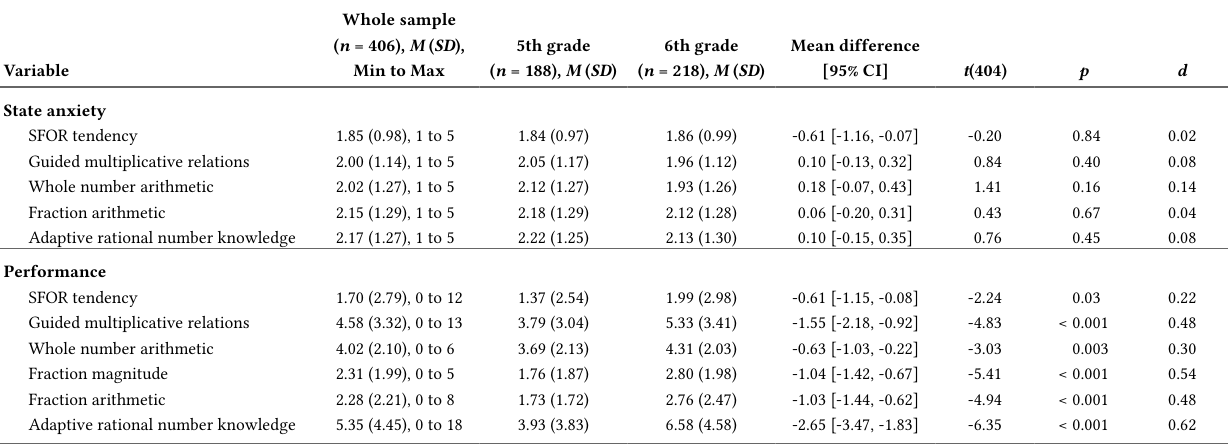
Descriptive Statistics for State Mathematics Anxiety and Performance With Independent Samples